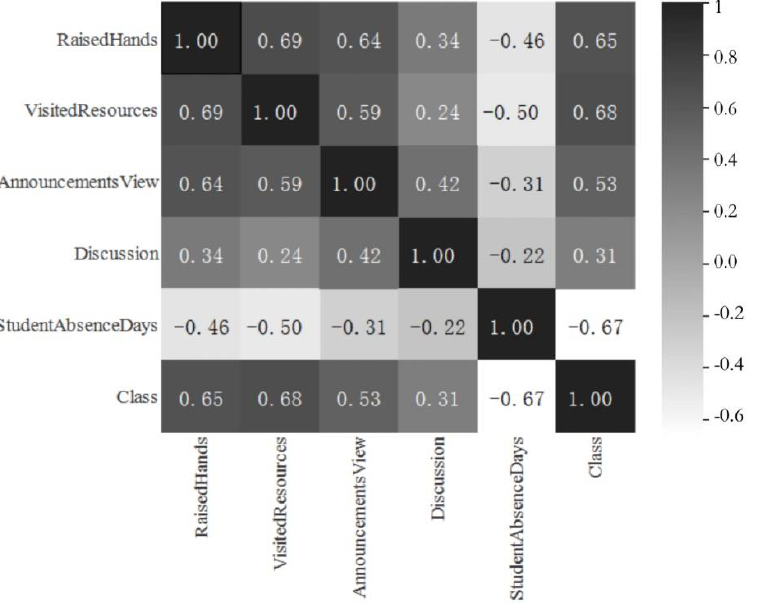
Figure 2. Thermodynamic diagram of the correlation coefficient between online learning behavior characteristics and grades.